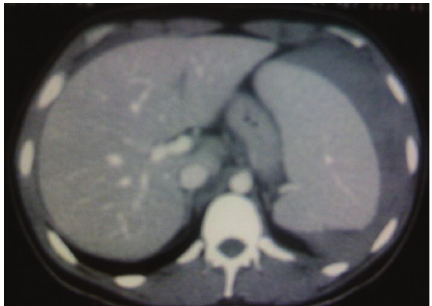
Figure 3: Urgent abdominal computerized tomography (CT) showed an enlarged spleen and splenic hematoma with the presence of free intraperitoneal fluid.